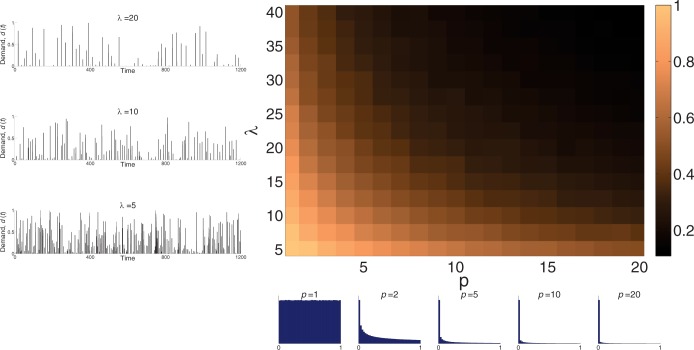
Influence of peak-demand parameters on the steady-state population distribution.Mean of population distribution as function power of the amplitude distribution, p, (bottom) and the mean time between events of demand, λ (left). The graph demonstrates that short time between bursts of peak-demand and high probability of high-amplitude demand results with a selection of population with high glycolytic capacity. Simulation parameters: kdrift = 0.05, Αhaz = 1, Αopp = 1, Αfix = 1 and m = 0.01. Detail description of the simulation process can be found in S3 Appendix.